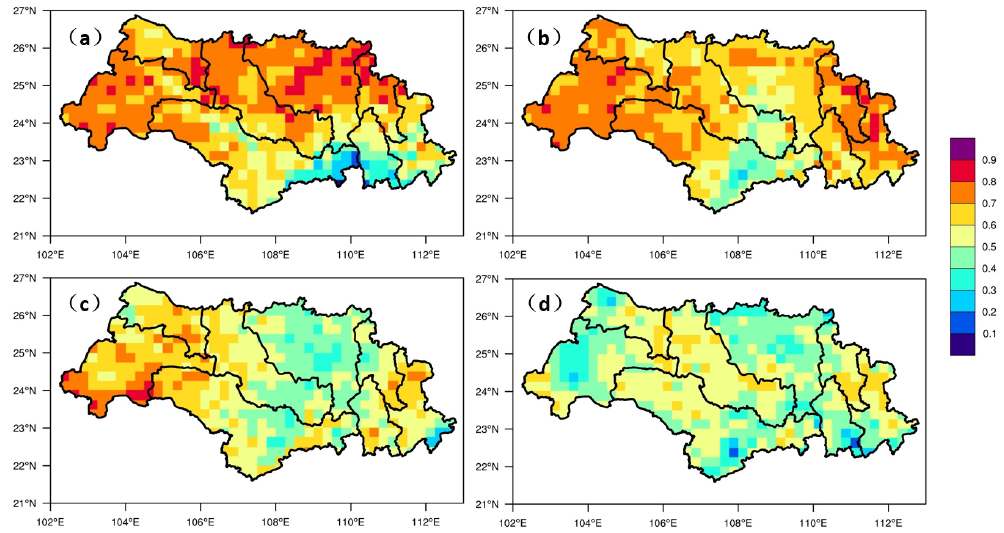
Figure 7. Study region maps showing the spatial distribution of correlation coefficient (R) in the Xijiang Basin. ( a ) 24 h lead time; ( b ) 48 h lead time; ( c ) 72 h lead time; ( d ) 96 h lead time.